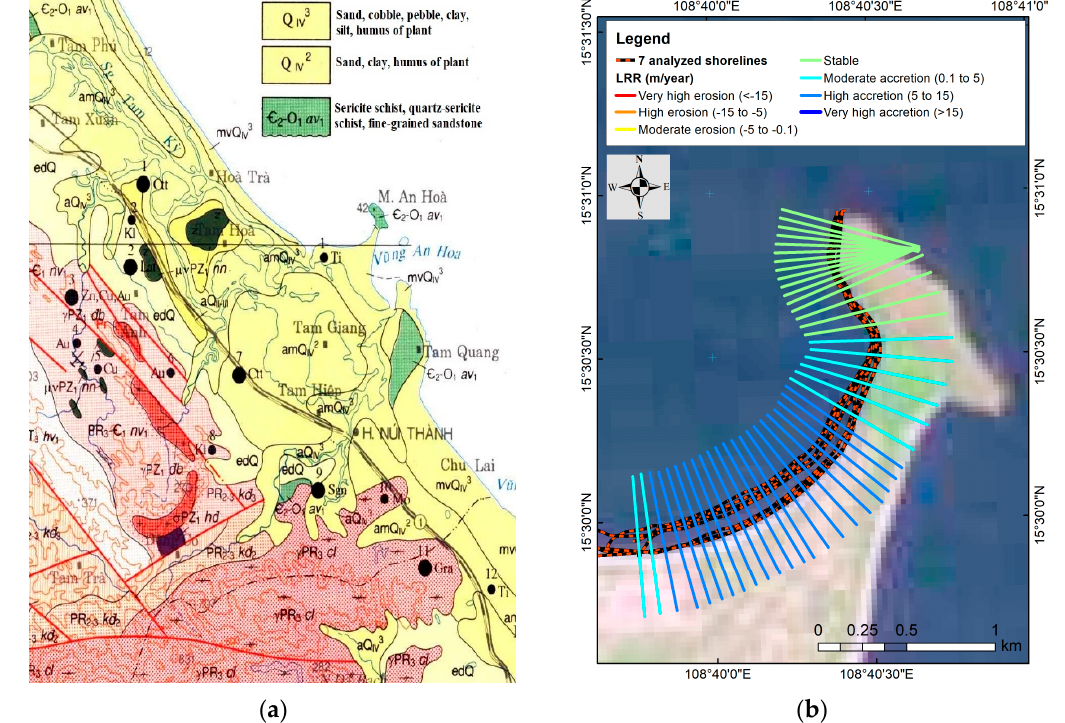
Figure 15. ( a ) Geological map (source: Vietnam Geological Survey Institution ) and ( b ) spatial variation of the coastline from Cua Lo estuary to An Hoa cape.